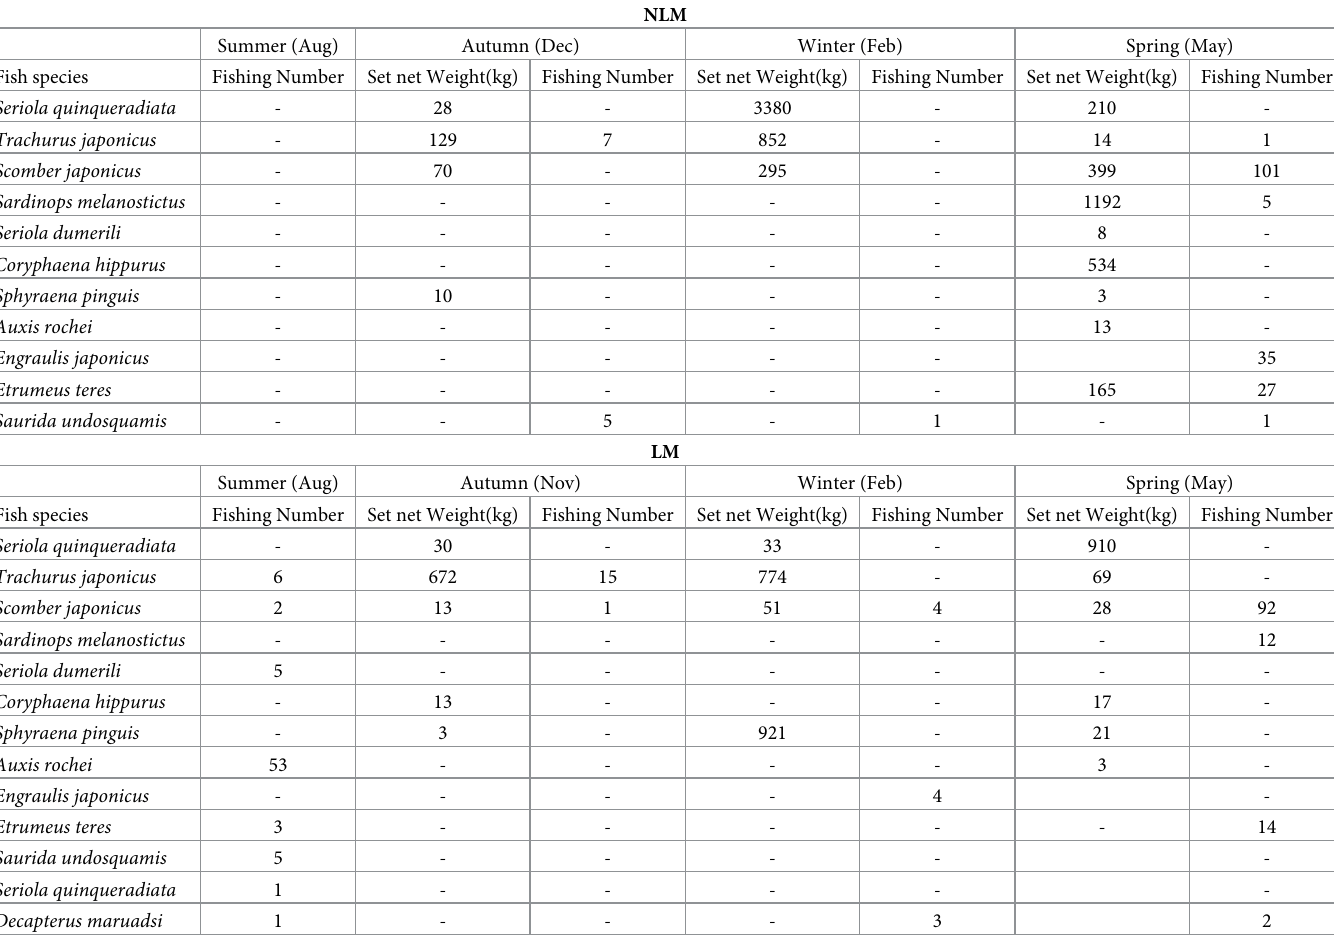
Table 4. Results of species composition, weight of fish in set net catches (expect summer), and number of fish by fishing in each survey period (except summer of